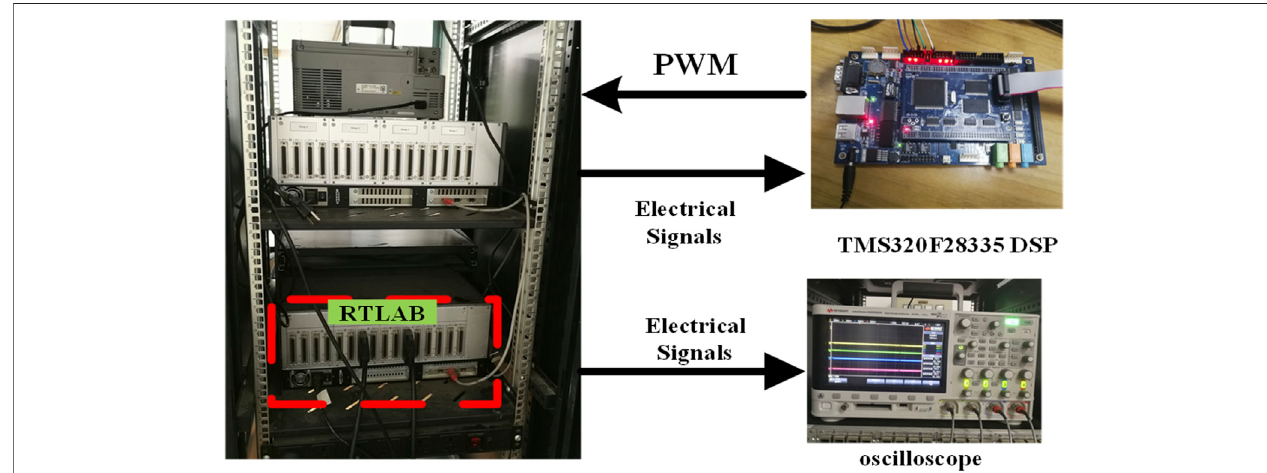
FIGURE 9 | HIL tests setup.